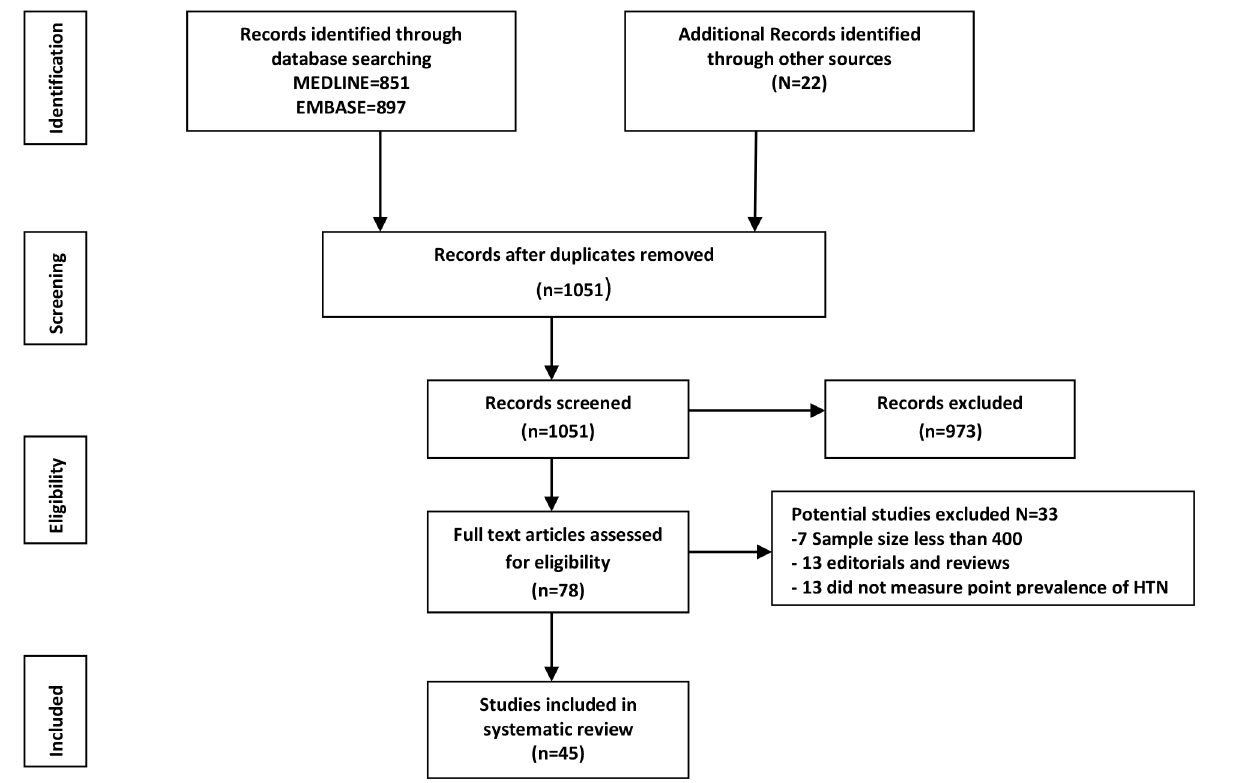
Fig 2. Study selection and extraction adapted from